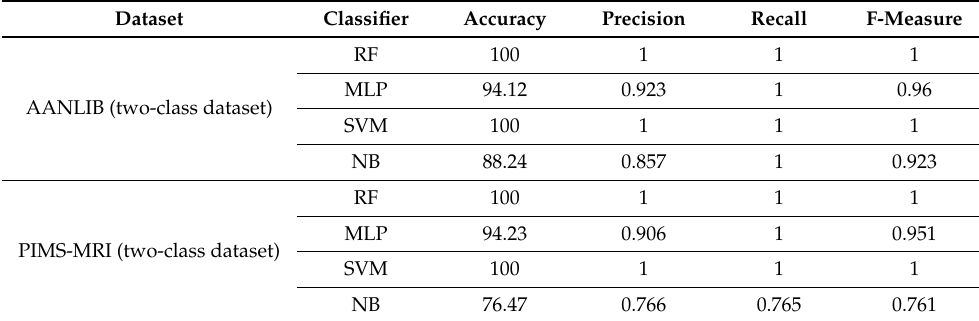
Table 4. Experimental Results for Validation Datasets (PIMS-MRI and AANLIB) using the proposed CNN feature-based method New validation results